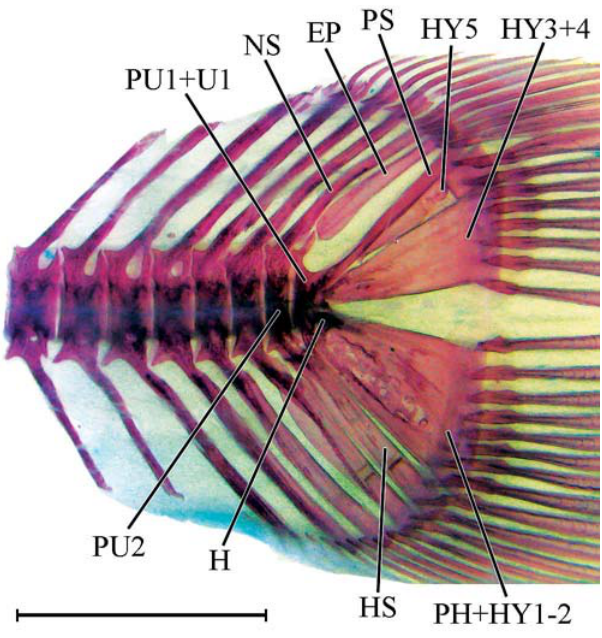
Fig. 9. Caudal skeleton in lateral view of Liosomadoras oncinus , MZUSP 105828, 99 mm SL. EP = epural, H = hypurapophysis, HS = hemal spine, HY = hypural, NS = neural spine, PH = parhypural, PS = pleurostyle, PU1+U1 = fused first preural and first ural centra, PU2 = second preural centra. Scale bar = 5 mm.